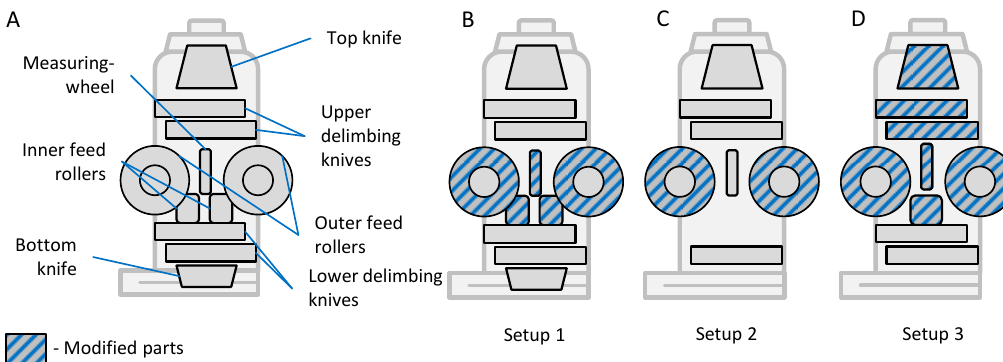
Figure 4. Modifications performed on three different harvesting head prototypes. ( A ) General overview of modifiable parts of conventional harvesting heads. ( B ) Tested S1 modifications (inner and outer feed rollers, measuring wheel). ( C ) Tested S2 modifications (feed rollers). ( D ) Tested S3 modifications (inner and outer feed rollers, measuring wheel, upper delimbing knives, top knife).